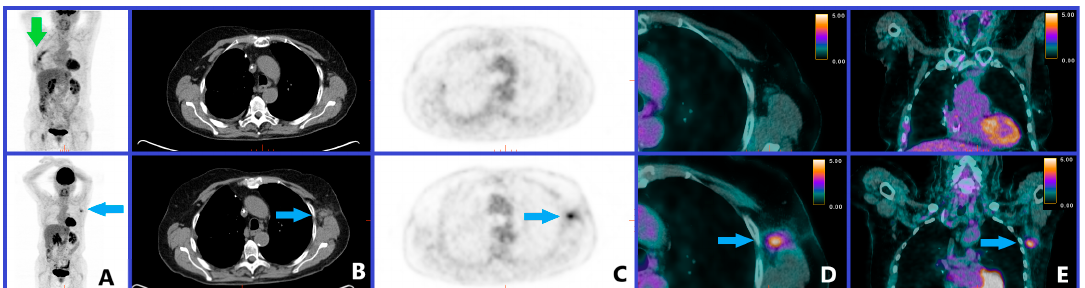
Figure 4. Clinical case of a patient with a previous history of treated left breast cancer and melanoma of the right leg with melanoma pulmonary metastasis recently operated. The images of the upper line show the PET/CT examination before the start of immune checkpoint inhibitor (pembrolizumab), and the images in the lower line show the PET/CT examination performed 9 months after the start of the treatment with (in A) a maximum intensity projection (MIP) PET image; in B, an axial CT slice; in C, an axial PET slice; in D, an axial PET/CT fused slice; in E, a frontal PET/CT fused slice. The green arrow on the pre-therapeutic PET MIP indicates the post-operative inflammation of melanoma pulmonary metastasis. The blue arrows on the follow-up PET / CT examination indicate that an intense left axillary lymph node uptake (SUVmax 4.7) appeared, which was considered suspicious of disease progression when it was found to be an inflammatory reactive lymph node in histological